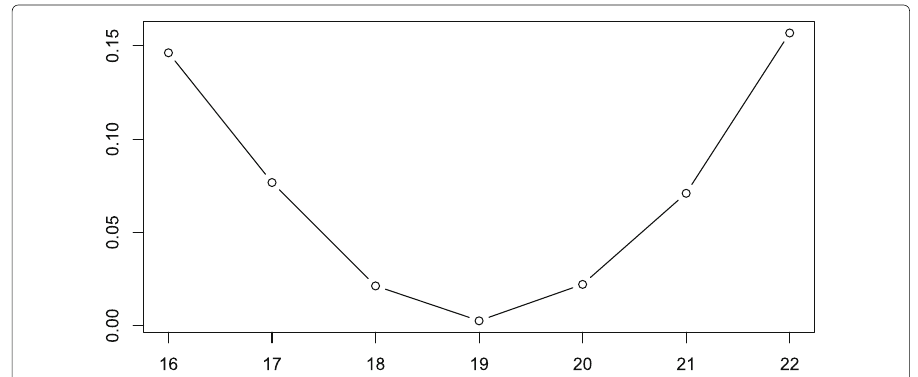
X t = cos ( 90 π t ) + cos ( 10 π t ) into two components by the proposed method with a range of τ = 18 to 23. Figure 26 shows the differences between the extracted high-frequency component and the true component cos ( 90 π t ) over the range of τ . As one can see, the results are robust to the choice of the size parameter τ value.